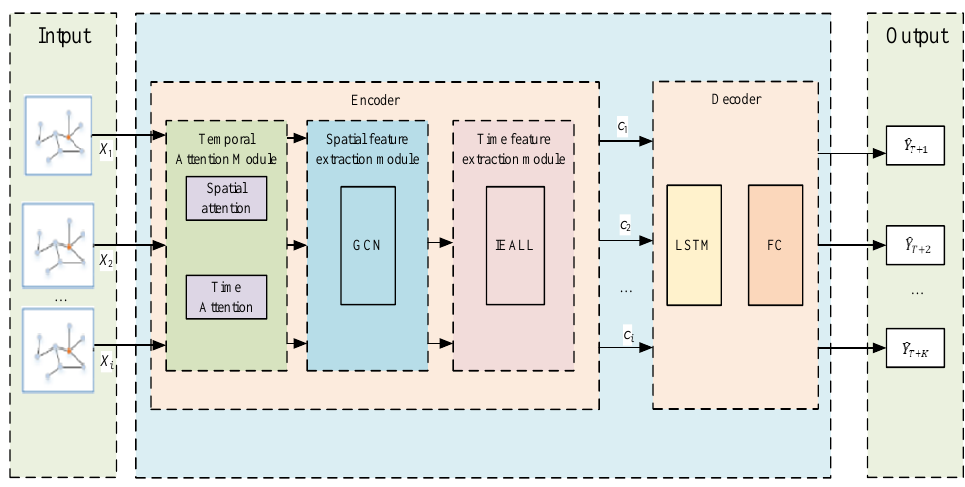
Figure 4. Overall framework diagram of STAGCN-IEALL.